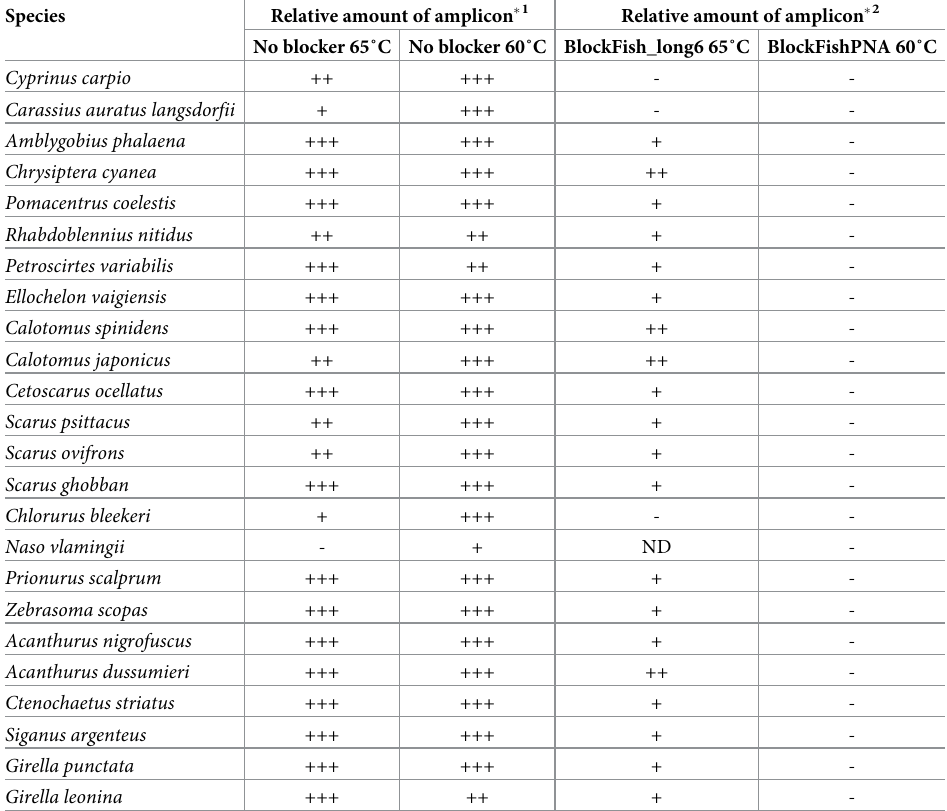
Table 4. PCR amplification of herbivorous fish 18S rDNA and suppression of the amplification with the